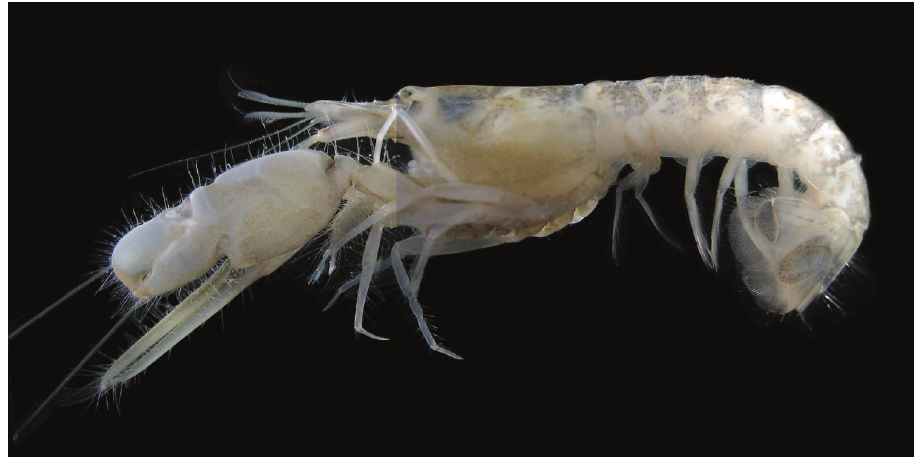
Figure 1. Alpheus margaritae sp. n. Female paratype from Isla Costa Azul, Santa María-La Reforma costal lagoon, Sinaloa, Mexico (EMU-10581), lateral view, color in